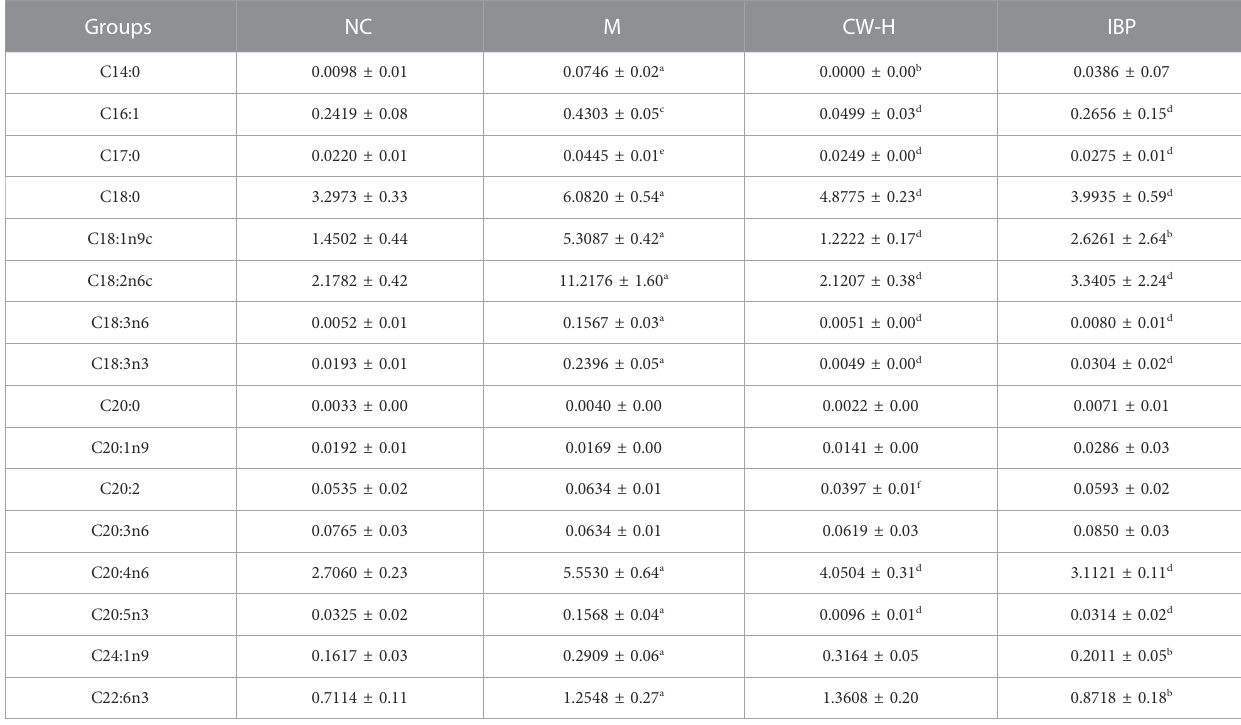
TABLE 1 Effect of CW on the FA content of the liver of model rats (x ‾ ± s, n = 6, μ g/mL).